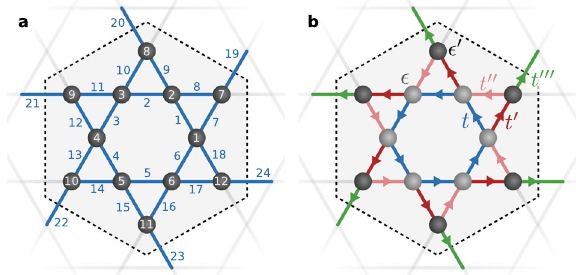
Fig. 2 2 × 2 kagome supercell. a Symmetric 2 × 2 kagome supercell. The unit cell, delimited by black dashed lines, contains 12 distinct sites. The 24 independent nearest-neighbor links are colored in blue. Sites and links are labeled counter-clockwise. b Schematic repre- sentation of the hoppings and onsite potentials in the 2 × 2 unit cell with C 6 symmetry. Spheres of different colors represent different onsite terms. Symmetries dictate equality of hoppings, as indicated by the colors of the bonds. The direction of the arrows signi fi es c j ), and has been chosen hopping from site j to site i (i.e., c y i arbitrarily, however, adhering to the constraints imposed by the C 6 symmetry.